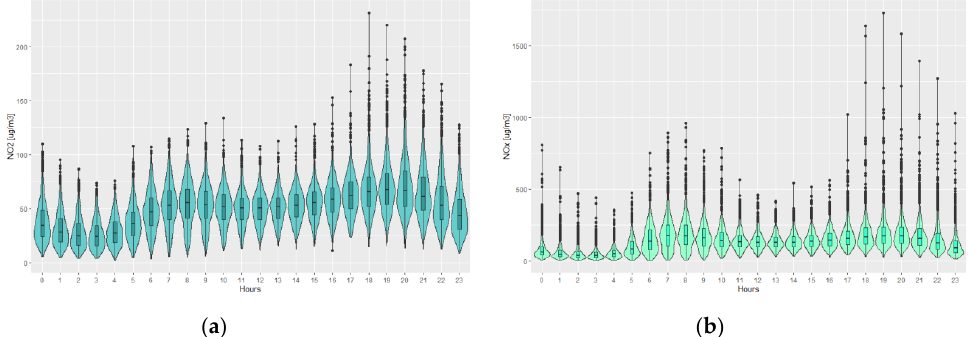
Figure A2. NO 2 ( a ) and NO x ( b ) daily variability in analyzed period 2015–2017.